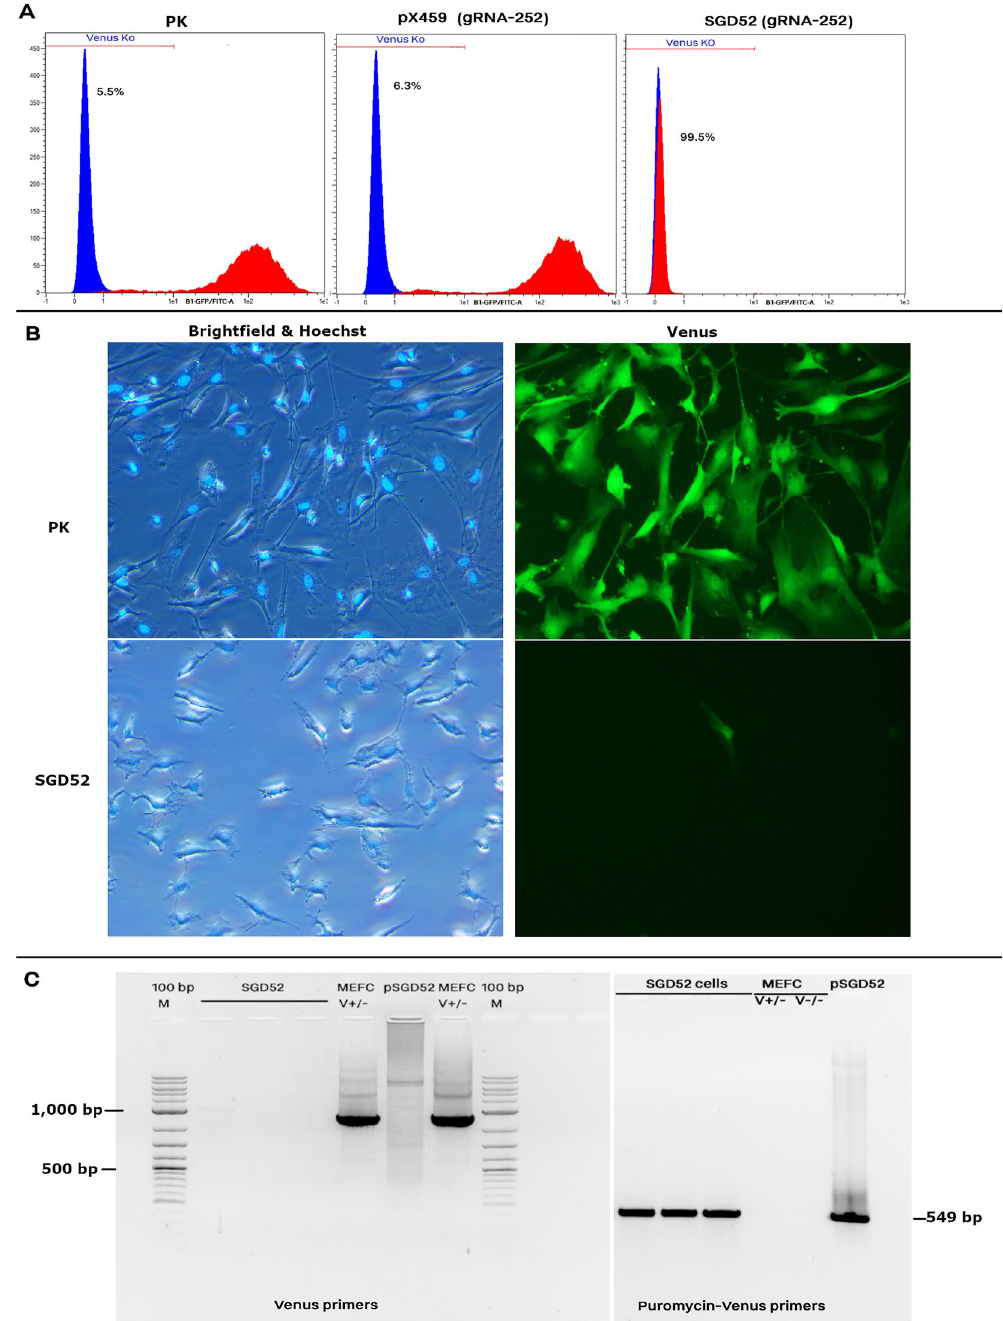
Figure 2. HDR-mediated Venus knock-out using the SGD52 construct. The MEF cells carrying a single copy of Venus were electrotransfected with either pX459 plasmid expressing gRNA-252 and Cas9, or the SGD52 vector expressing gRNA-252 and Cas9 and puromycin plus an HDR cassette. The pSGD52-electrotransfected cells were selected against puromycin for 105 days. In parallel, cells from the pX459-252 and the non-transfected cells (positive control), expressing a single copy of Venus, were also cultured for 105 days. ( A ) Results of FACS analysis. The Venus expression pattern of PK and pX459/ pSGD52-electroporated cells are shown in red color. The MEF cells with no Venus transgene was considered as the negative control and was depicted in blue color. ( B ) Fluorescence microscopy and ( C ) PCR. Two sets of primers were used to amplify the Venus transgene and the Puromycin-Venus. Specific primers for Venus could detect only the wild type copy of Venus transgene under the CAGGS promoter in non-transfected cells, but not the truncated Venus using the SGD cassette. The presence of the HDR-mediated SGD cassette was verified using specific primers covering the part of the puromycin transgene and the proximal part of the truncated Venus. The SGD cells are electrotransfected cells with pSGD